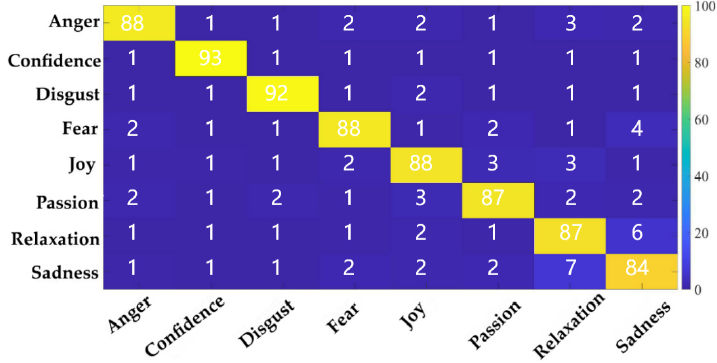
Figure 9. Confusion matrix of eight kinds of music.